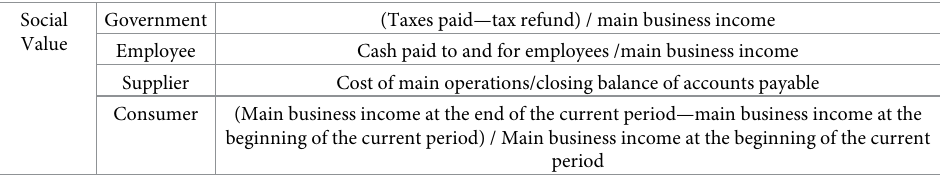
Table 1. Social value measurement calculation